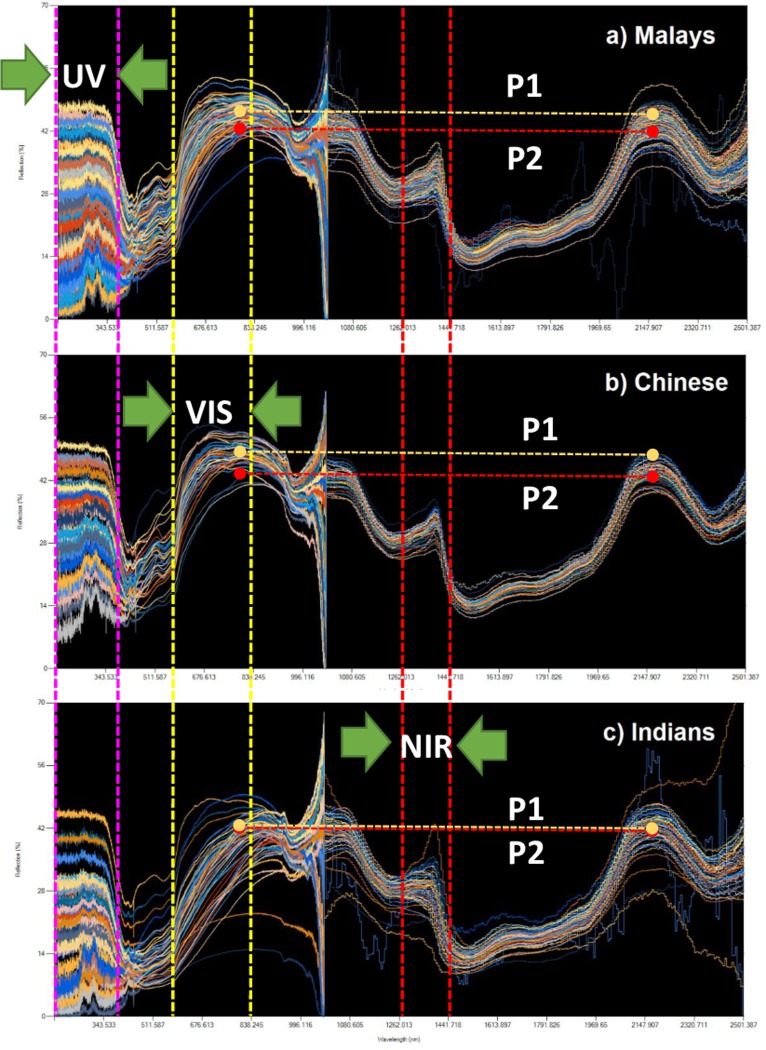
Decomposition of spectra between Malaysian Malays, Chinese and Indians.